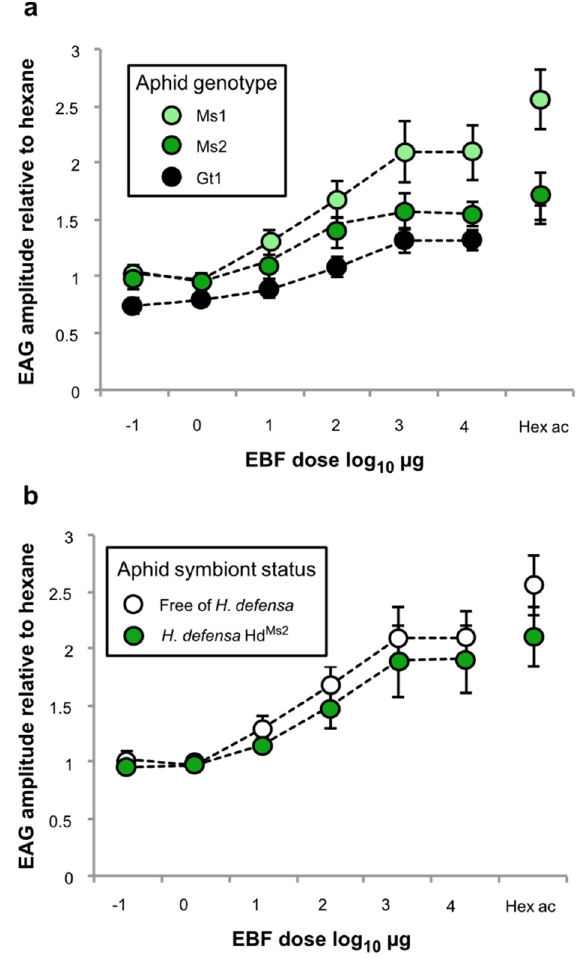
Figure 4. Relative electroantennogram (EAG) amplitudes in response to six EBF doses normalised with hexane responses for aposymbiotic individuals from the three A. pisum genotypes ( a ), and the Ms2 genotype with or without H. defensa ( b ). Error bars show the standard error. Detached points in the ( a ) and ( b ) graphs show normalised responses to cis-3-hexenyl acetate (a major volatile emitted by legume plants). EBF doses were log 10 -transformed for the analyses. N = 10 aphids for each stimulus and line.